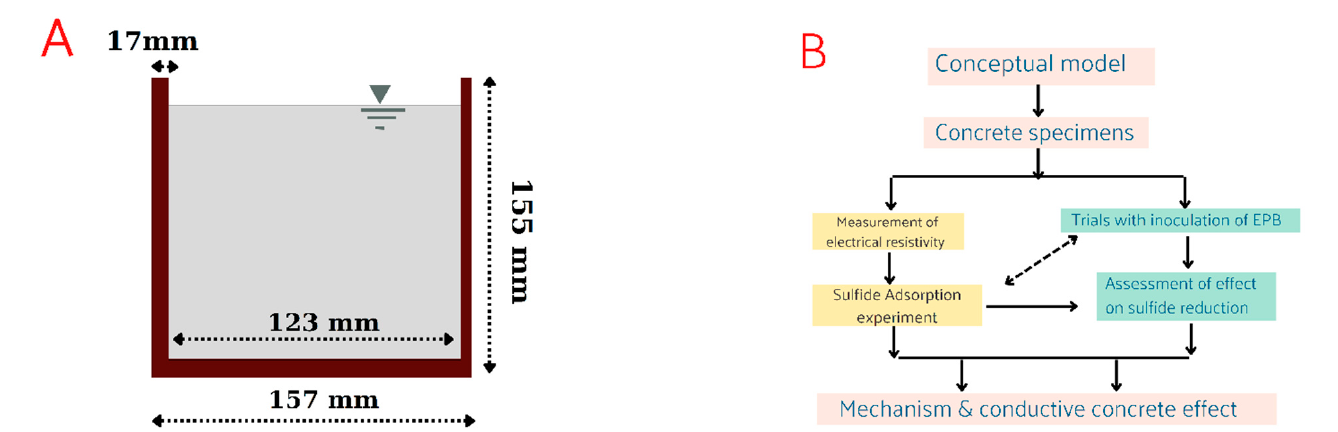
Figure 3. Geometry of the cup-shaped specimen produced ( A ) and the research methodology flowchart ( B ).